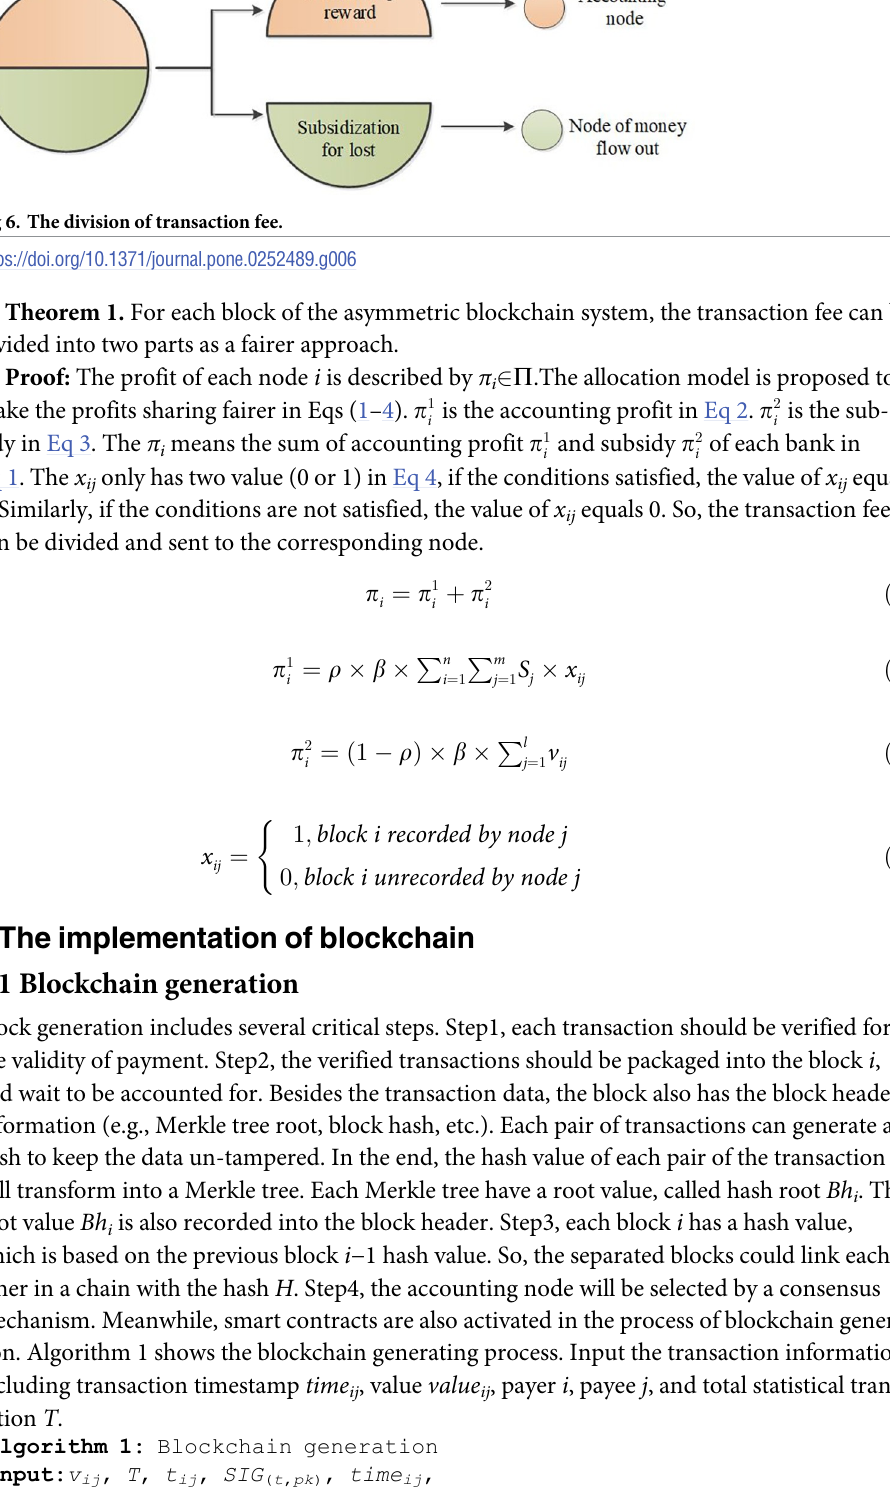
Algorithm 1: Blockchain generation